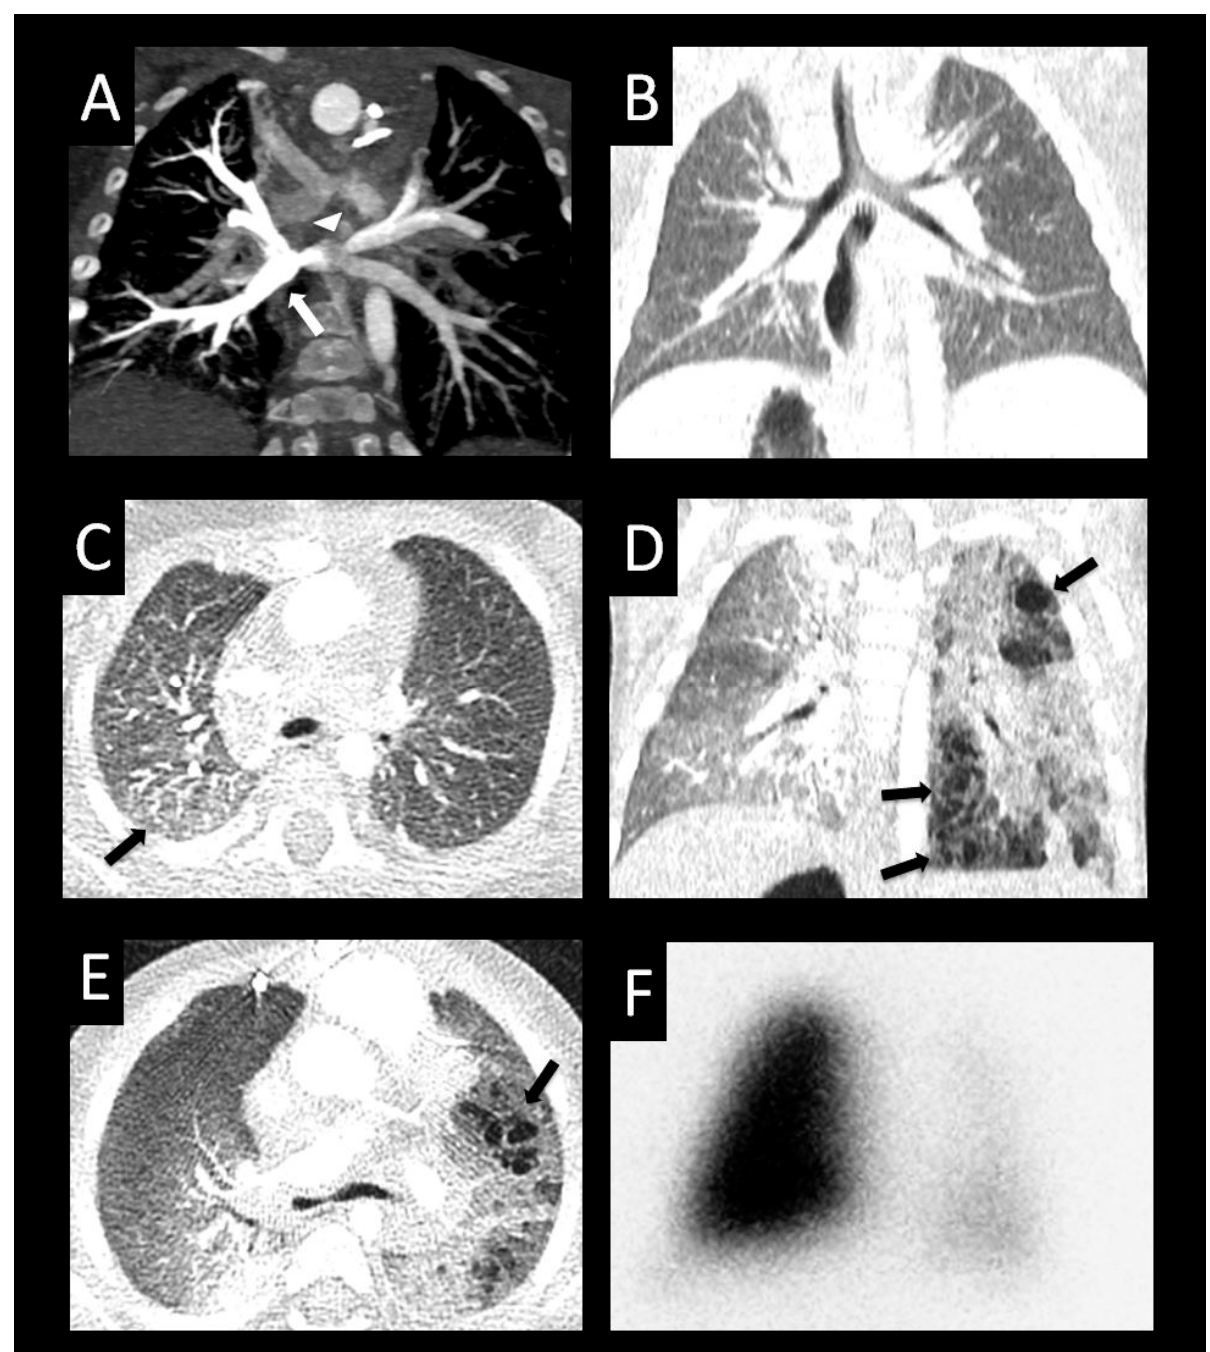
Figure 10. Development of lung cysts in progressive pulmonary vein stenosis. Heterotaxy syndrome, complete atrioventricular canal defect with supracardiac totally anomalous pulmonary venous connection, status post bidirectional Glenn shunt and totally anomalous pulmonary vein repair, with recurrent obstruction of the anastomosis of the central common pulmonary vein confluence to the left atrium. Right arm contrast injection ( A ) shows differential enhancement of the pulmonary veins (right > left), moderate ostial stenosis of the right common pulmonary vein (arrow), and moderate stenosis of the left upper pulmonary vein (arrowhead). Coronal ( B ) and axial ( C ) lung images show normal lungs with mild edema of the right lower lobe (arrow, ( C )). Coronal ( D ) and axial ( E ) images were performed 5 months after surgical repair of congenital heart disease with right-sided pulmonary vein repair. Note new development of architectural distortion with multiple cysts (arrows) throughout the left lung. The left-sided pulmonary veins were not visualized and were confirmed to be atretic at cardiac catheterization. Anterior perfusion scintigraphy image ( F ) with 11% left and 89%